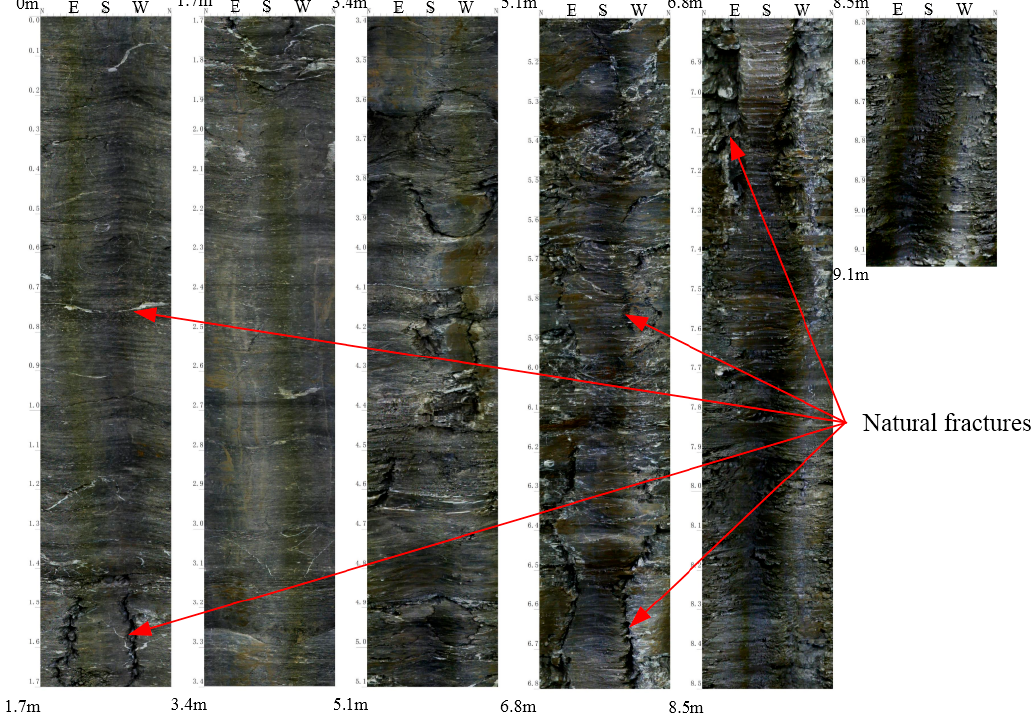
Figure 9. Optical televiewer image of the borehole drilled vertically in the roof at the Huahong coal mine, China.